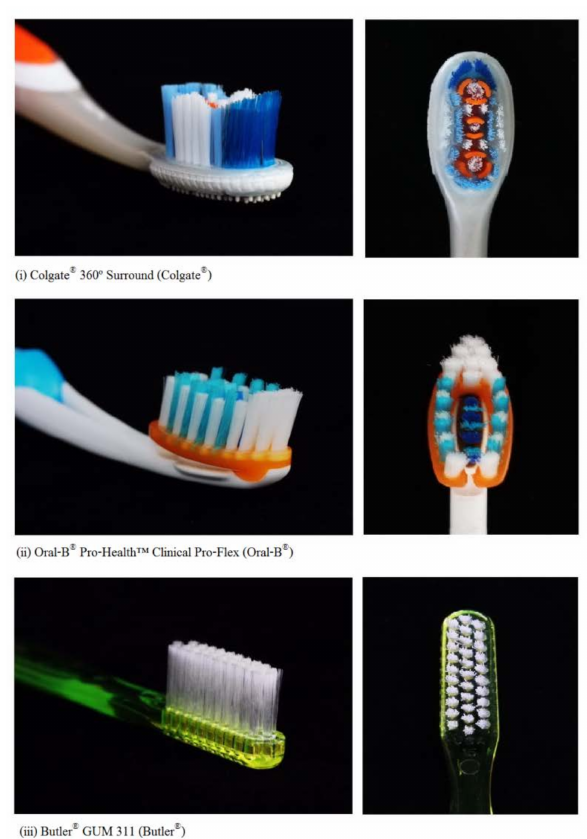
Figure 1. The three manual toothbrushes